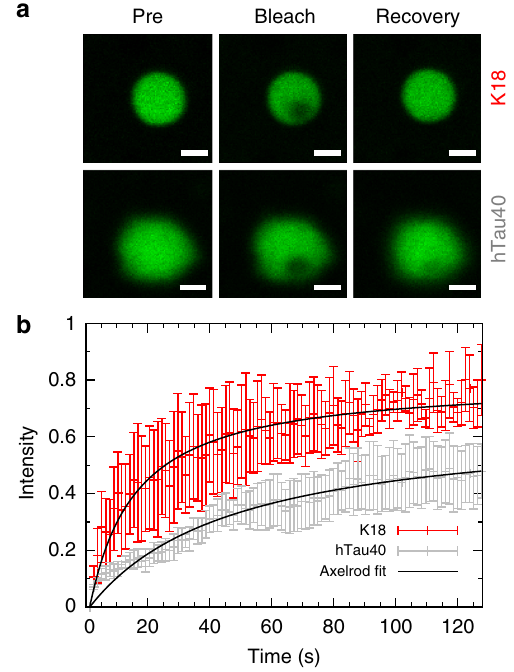
Fig. 5 Dynamics of tau in tau/RNA droplets. a FRAP images (recovery image 129 s after bleaching; scale bar 1 μ m). b Normalized FRAP recovery curves for hTau40 (50 µ M; gray) and K18 (50 µ M; red) droplets in the presence of 40 µ g ml − 1 polyU RNA (25 mM HEPES, pH 7.4). Symbols with error bars depict experimental results; black lines are fi ts assuming diffusion-controlled recovery (i.e., the Axelrod model). Error bars in b correspond to ± SD. Source data are provided as a Source Data fi